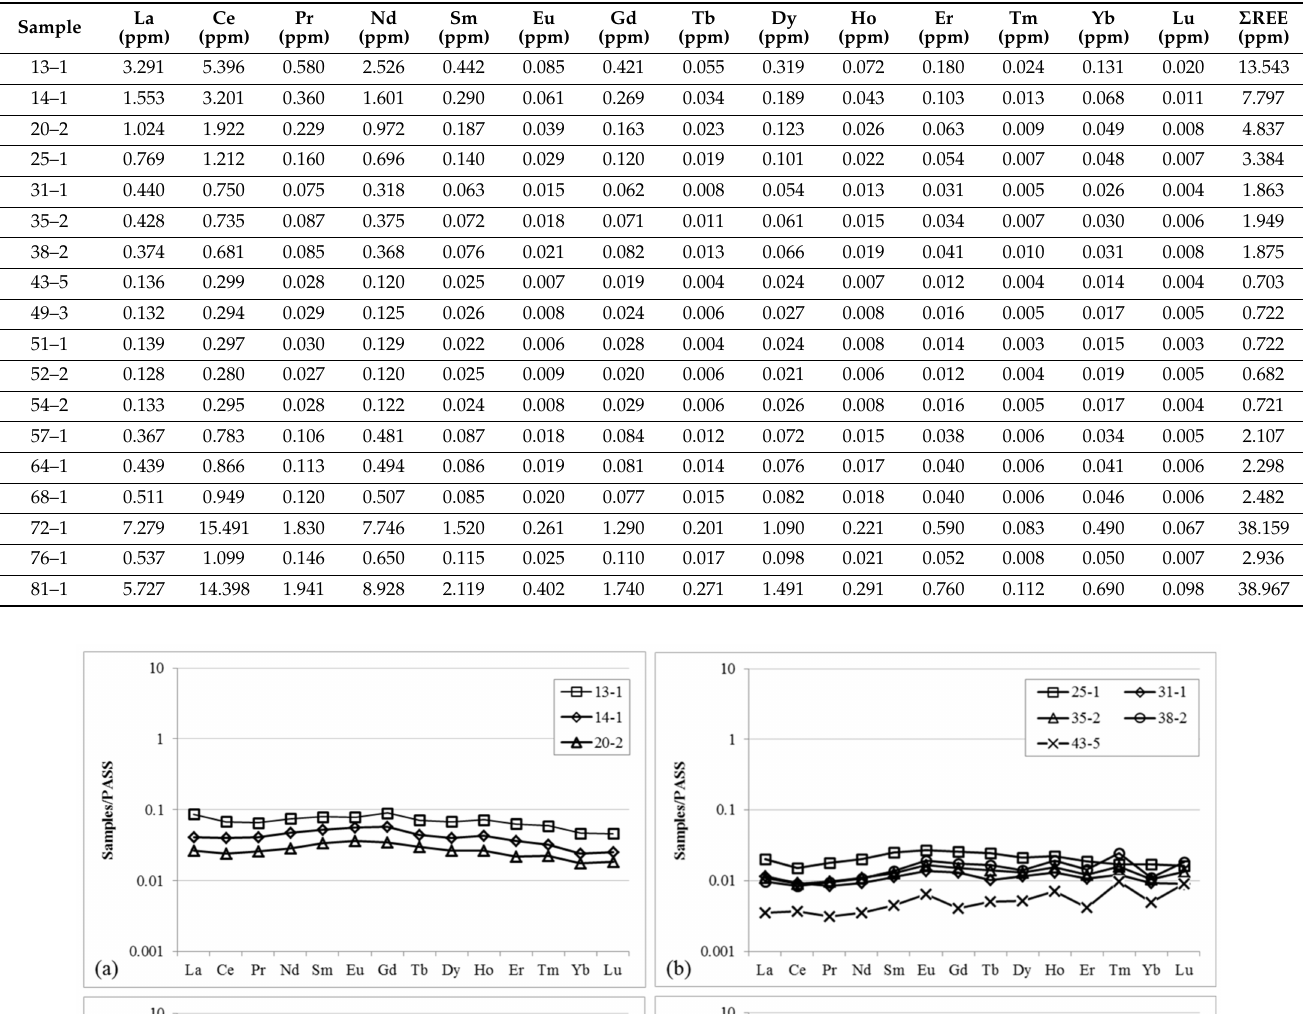
Table 3. REEs content of dolomite in Xiaoerblak Formation.